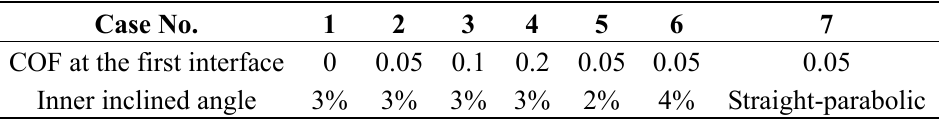
Table 4. Numerical cases of the inner cone bonding